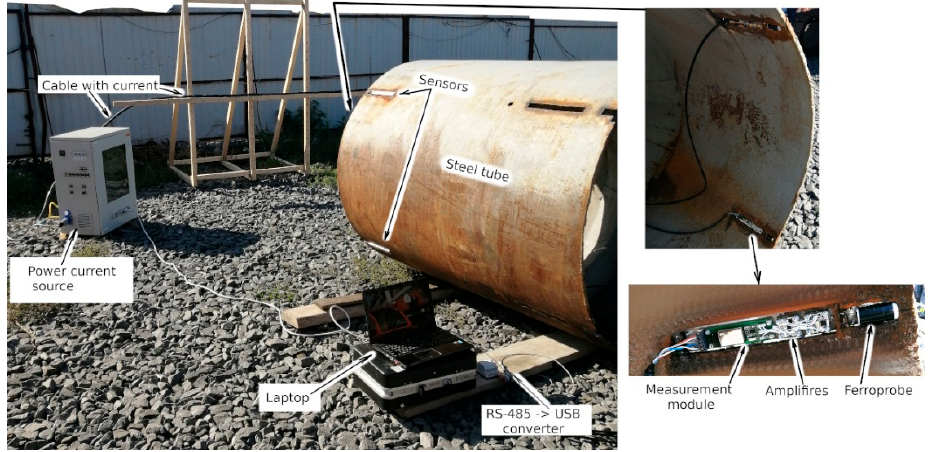
Figure 13. Experimental facility model.